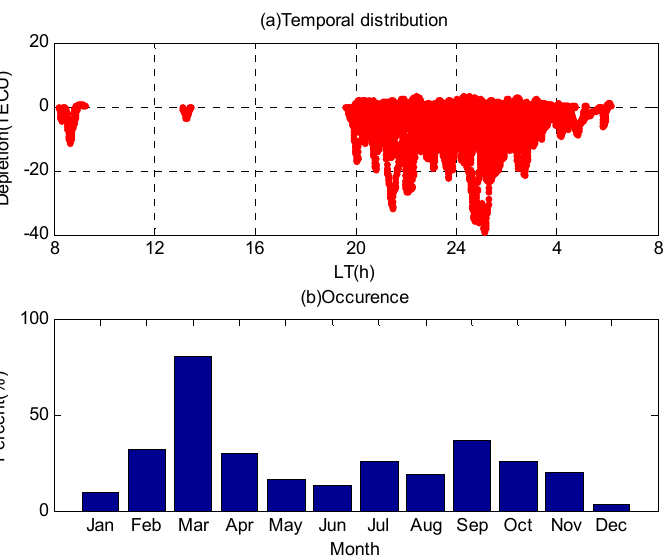
Figure 4. Temporal distribution of EPBs (top panel) and percent distribution of EPBs occurrence (bottom panel) detected by station HKKT during 2014. “LT” represents local time in Hong Kong.